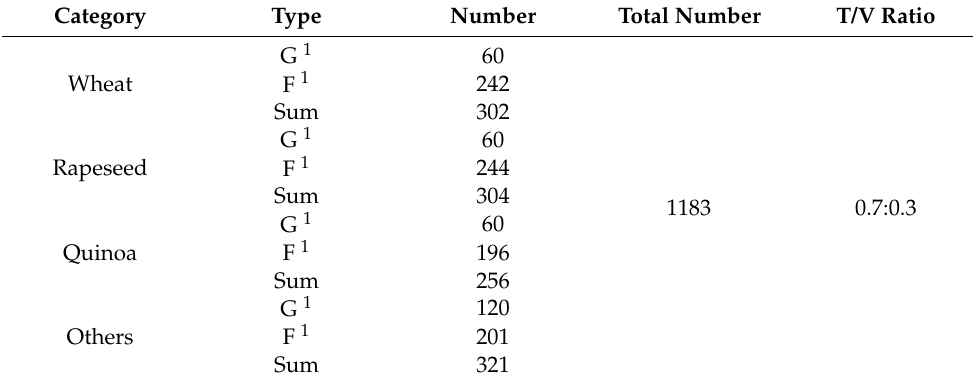
Table 1. Sample selection and